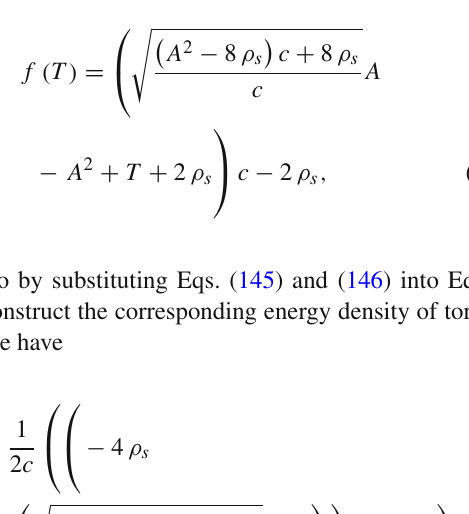
Fig. 10 All plots show ξ 1 , 2 with χ 1 , 2 versus a for dust-torsion system for GCG. We use c = 3 and A = 0 . 8 for all numerical